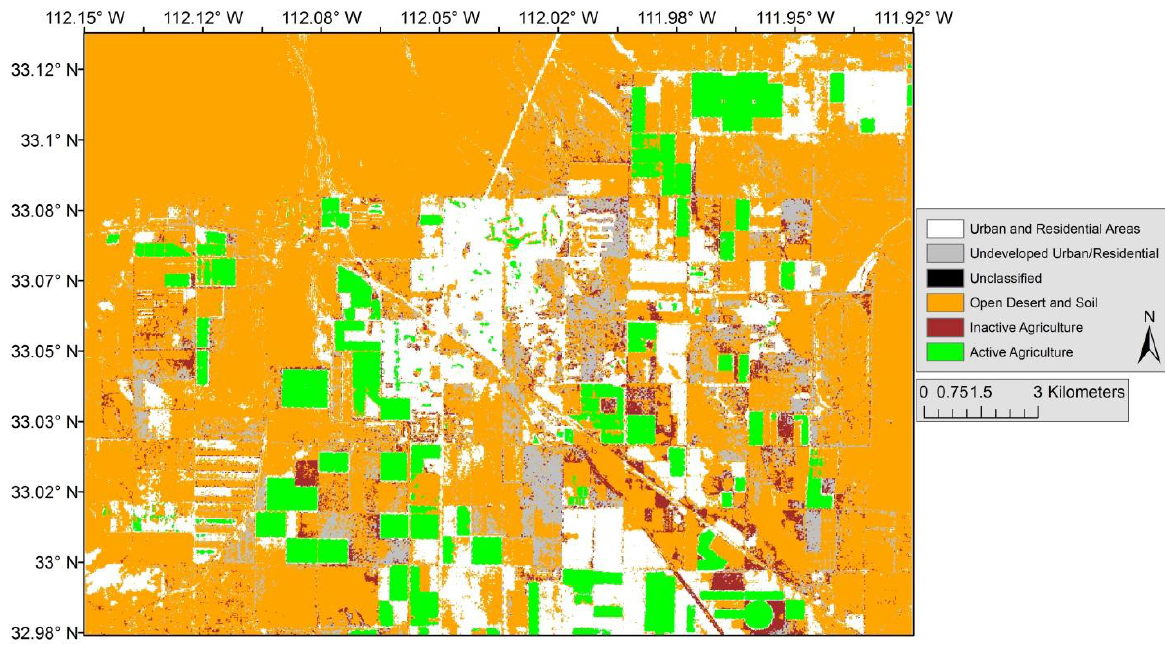
Figure 8. Supervised land-use classification.